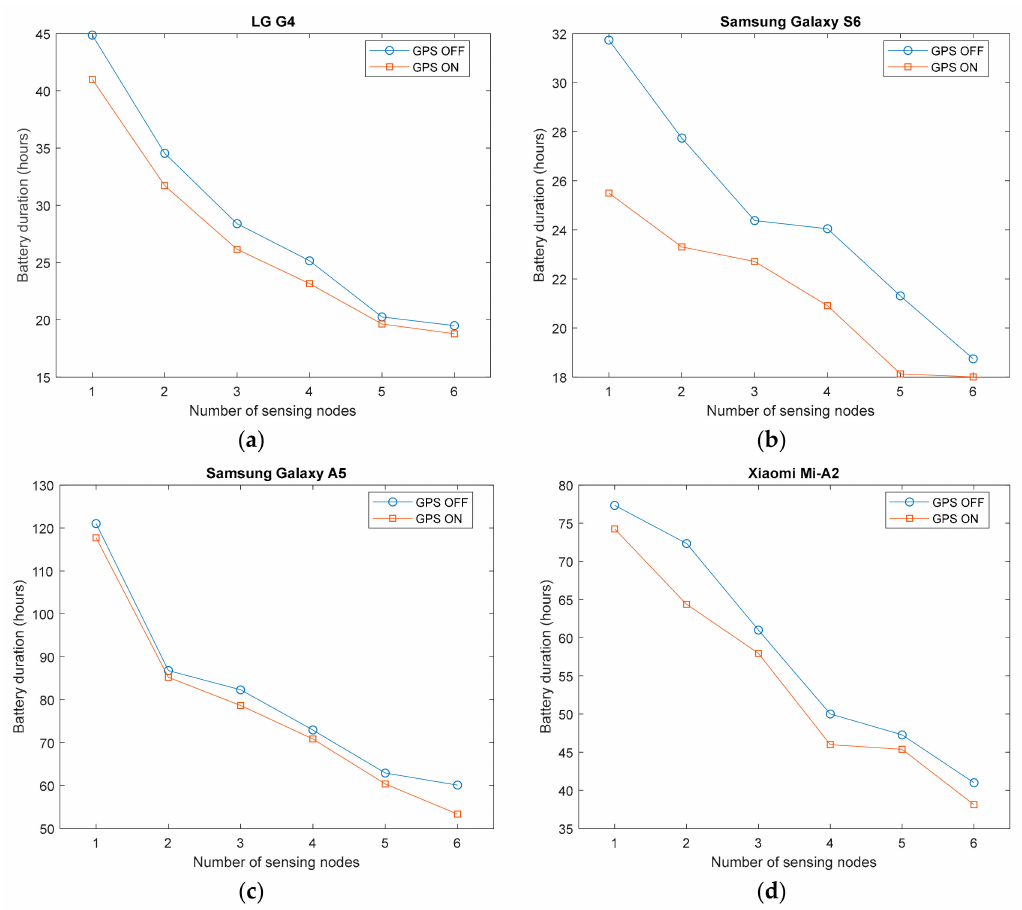
Figure 4. Battery duration as a function of the number of connected sensors for a sampling period of 20 ms (sampling rate of 50 Hz) depending on the use of the localization services for the di ff erent smartphones: ( a ) LG G4; ( b ) Samsung Galaxy S6; ( c ) Samsung Galaxy A5; ( d ) Xiaomi